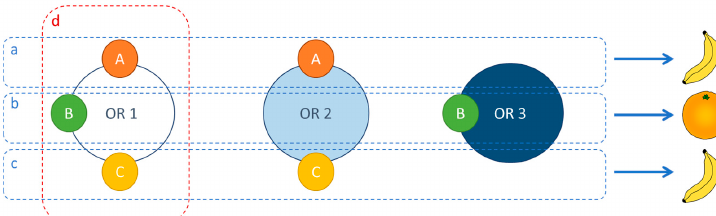
Figure 8. Olfactory receptor (OR) responses to odorants. Humans have approximatively 396 olfactory receptors (OR 1, OR 2, OR 3, etc.). A single olfactory receptor is able to recognize different odorant molecules. As an example, OR 1 is able to recognize molecules A, B, and C (d). The identification of a particular odorant is caused by the activation of a group of receptors with a special pattern (a, b, and c). For example, odorant A is recognized by OR 1 and OR 2 as a banana flavor ( a ). Molecule B is, in turn, recognized by OR 1 and OR 3 and identified as an orange flavor ( b ). Also, two distinct molecules can be recognized by the same receptors and identified as having the same odor (a and c). Indeed, odorant C is also recognized by OR 1 and OR 2 as a banana flavor ( c